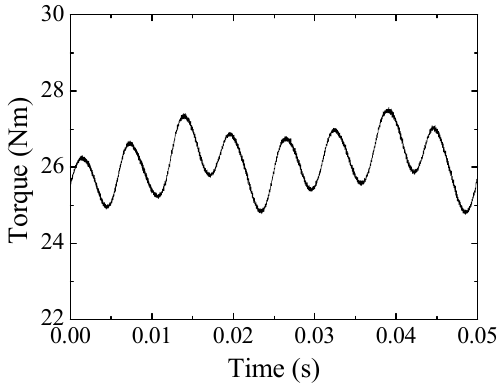
Figure 17. Tested load torque at the speed of 800 rpm.